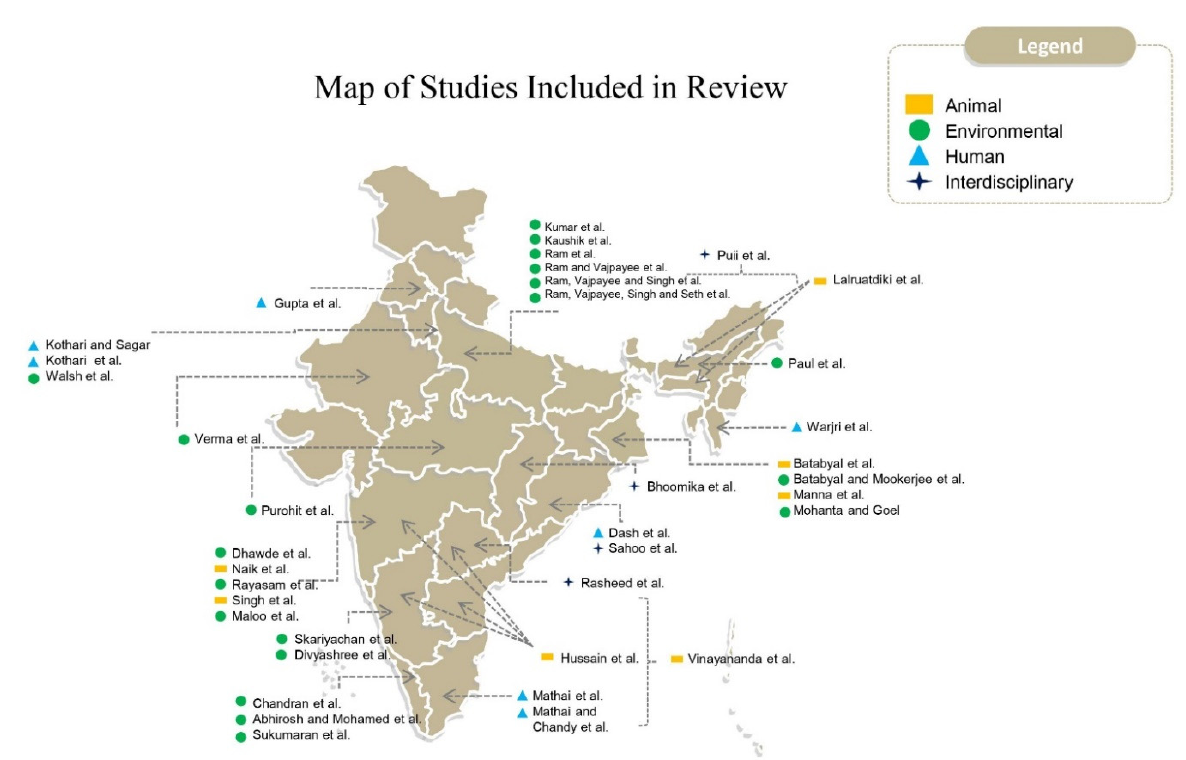
Figure 3. Map of the location of the studies and the focus of the study included in this